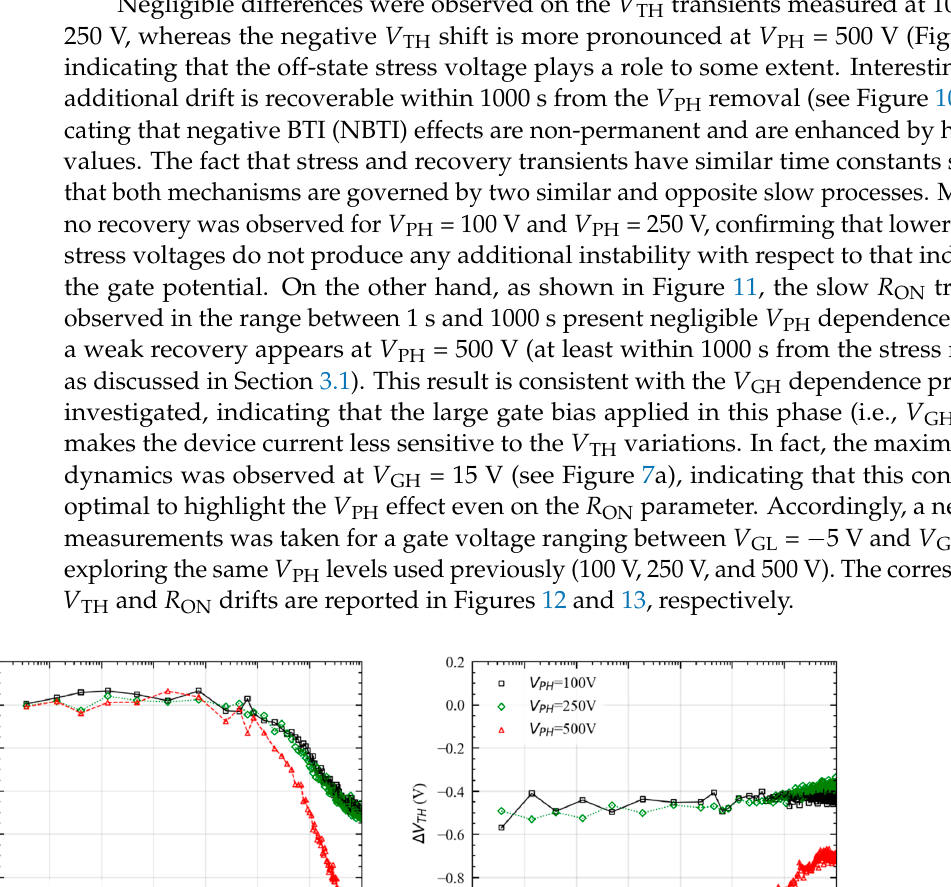
Figure 11. ( a ) Effect of drain off-state stress voltage (100 V, 250 V, and 500 V) on the R ON drift during the stress with V GH = 20 V. At an increasing stress voltage, the R ON drift retained after 1000 s does not change significantly. ( b ) Monitored R ON recovery for different drain stress voltages.